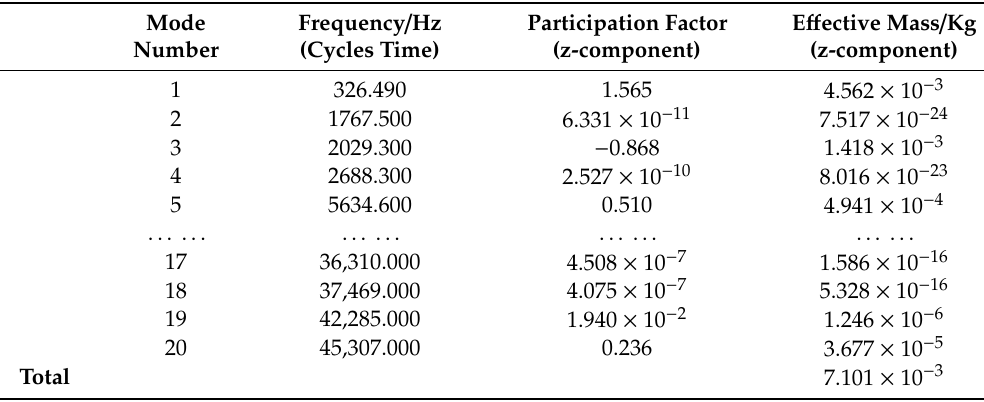
Table 4. Frequency, participation factor and e ff ective mass for 20 eigenvalues.